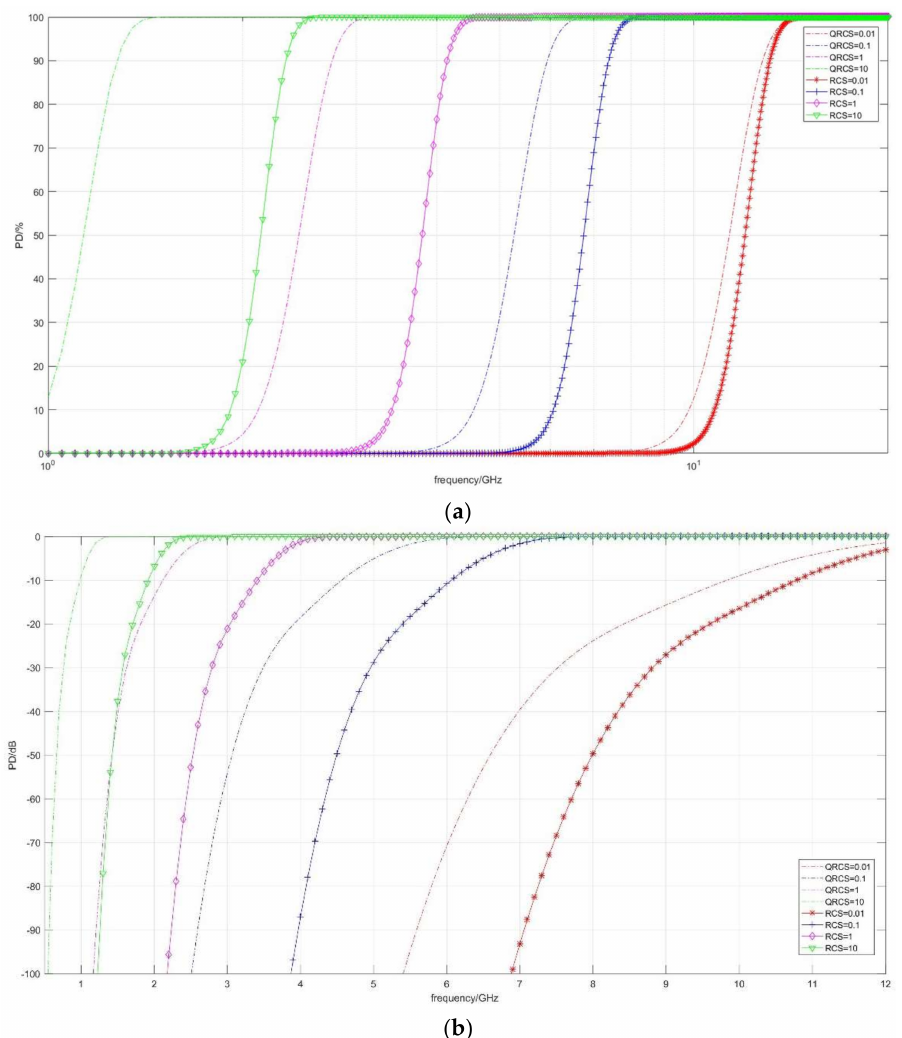
Figure 6. Correlation diagram of detection probability changing with frequency (taking RCS and QRCS). ( a ) P D /%, ( b ) P D